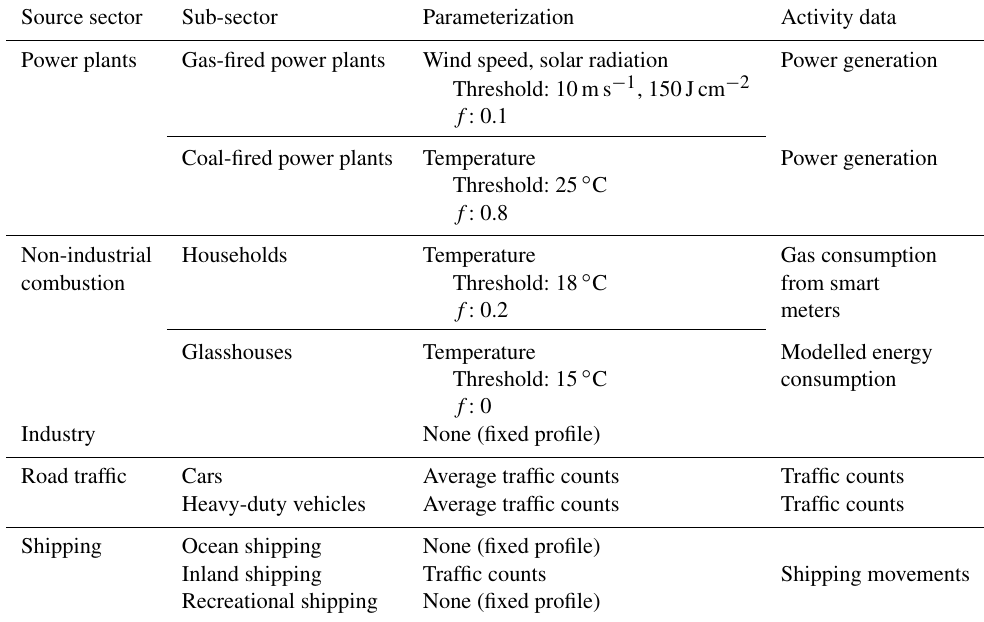
Table B1. Overview of the data used to create the temporal profiles presented in Sect. 2.1.2. The activity data represents the actual and the parameterizations are based on environmental variables or other